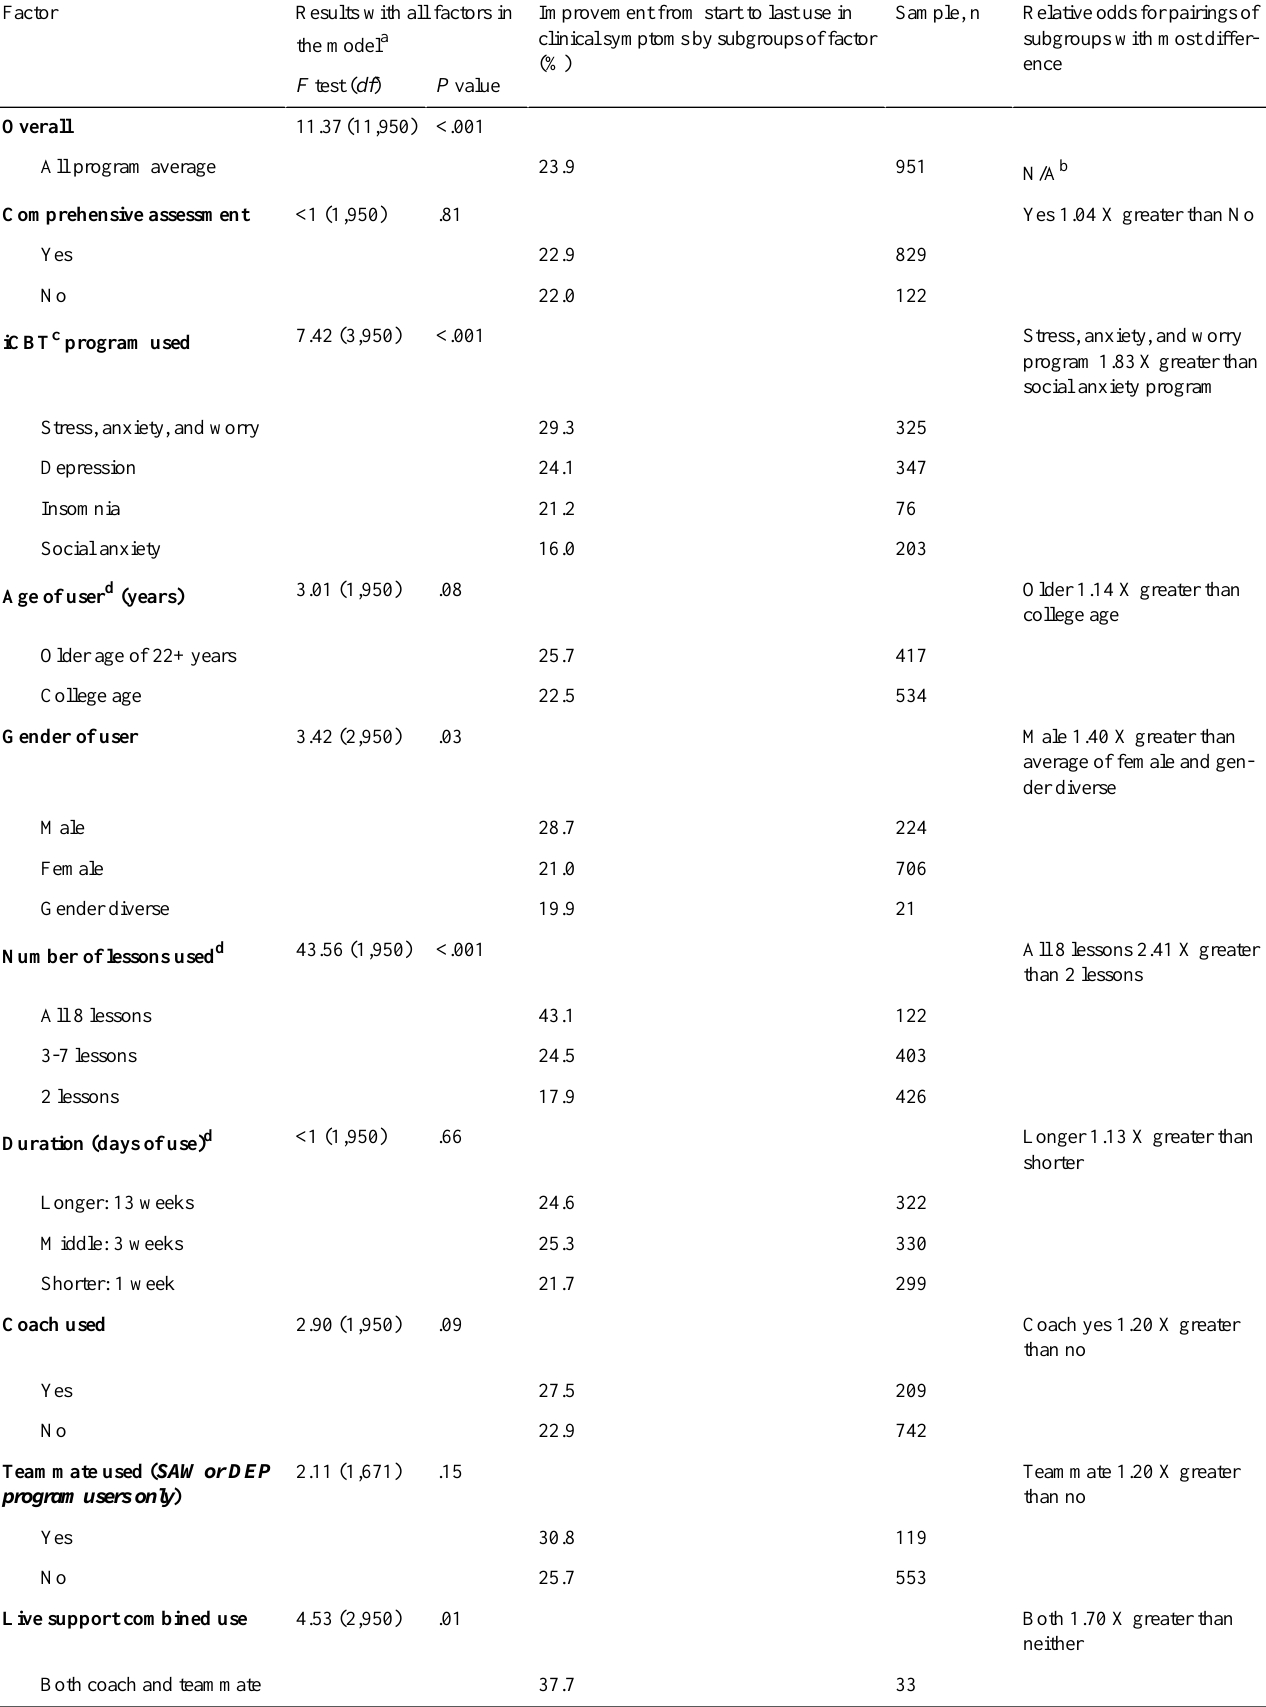
Table 4. Main effect tests of each factor on the outcome of reduction in clinical symptoms when controlling for other factors: total sample (N=951). (%)Results with all factors in clinical symptoms by subgroups of factor the model